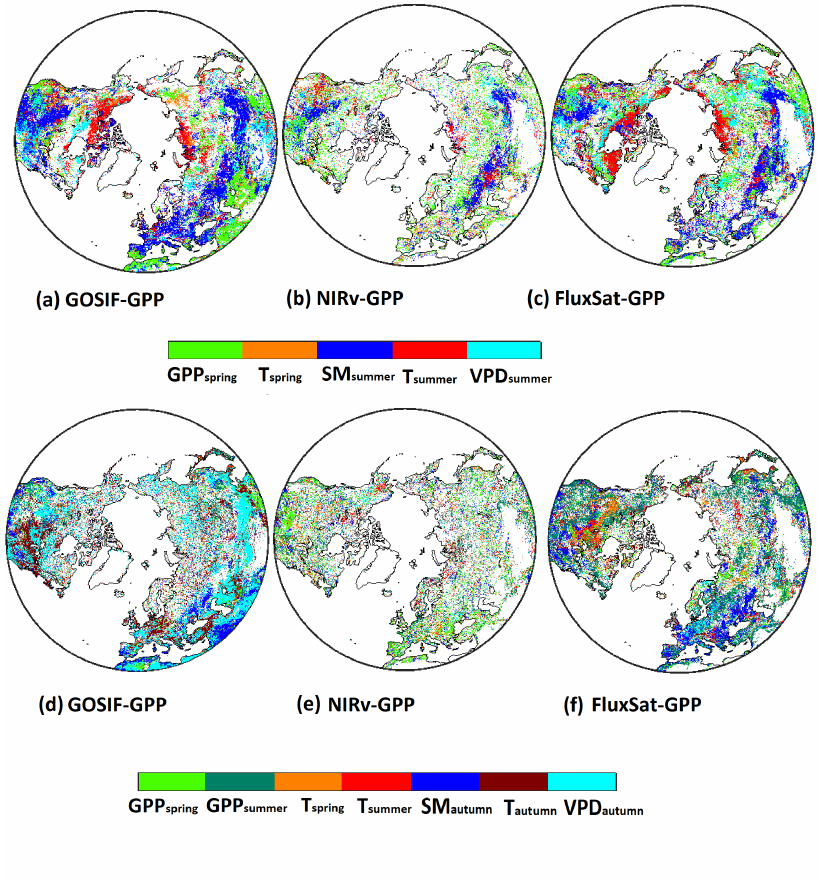
Figure 6. Dominant variables that explain variance of GPP summer ( a – c ) and GPP autumn ( d – f ) for the three GPP products (i.e., GOSIF-GPP, NIRv-GPP, and FluxSat-GPP). The dominant driver was identified based on the highest correlation coefficient (absolute